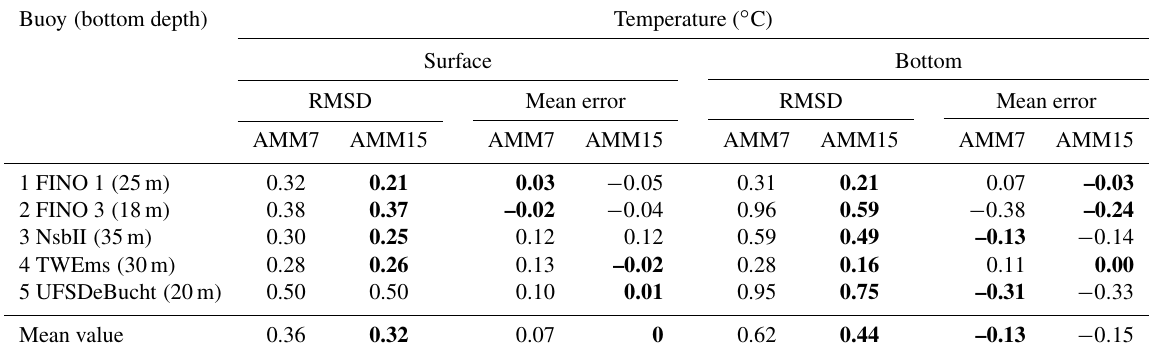
Table 9. Yearly mean (2017) RMSD and bias statistics at the five moorings in the German Bight (observation–model). Surface and bottom temperature are for AMM7 and AMM15. The values in bold indicate an improvement. Buoy ( bottom depth ) Temperature ( ◦ C) Surface